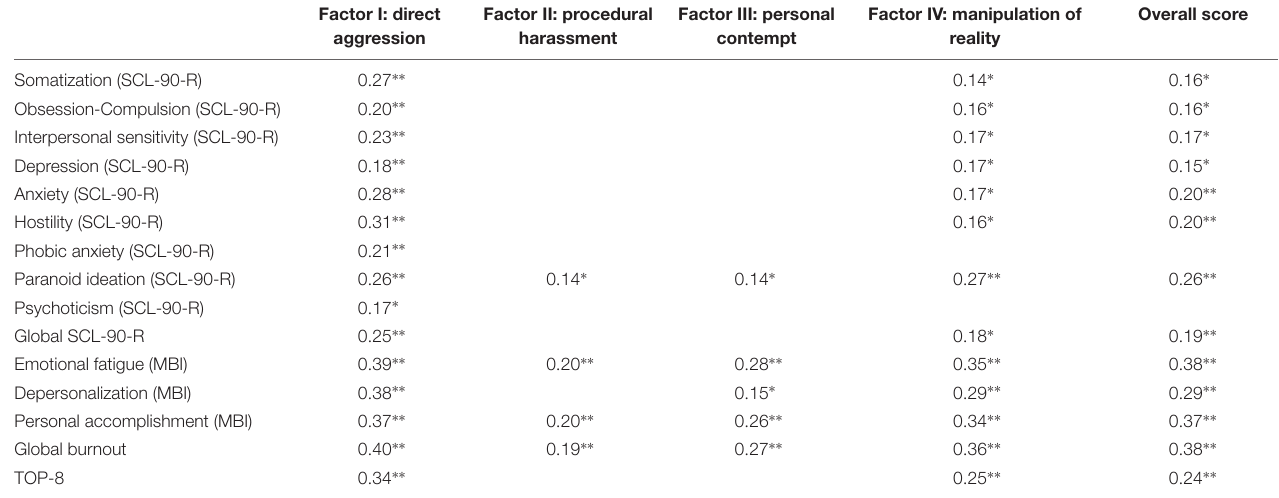
TABLE 3 | Pearson’s correlations between LHS and other tests.